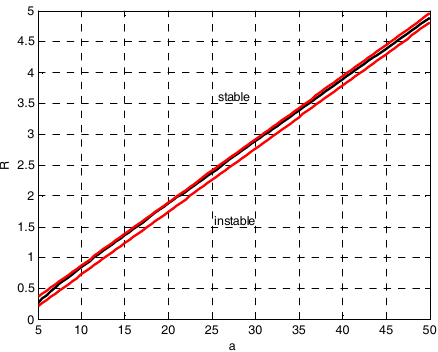
Figure A2. Stability and instability regions (in red lower and upper bounds of separation between the two regions).